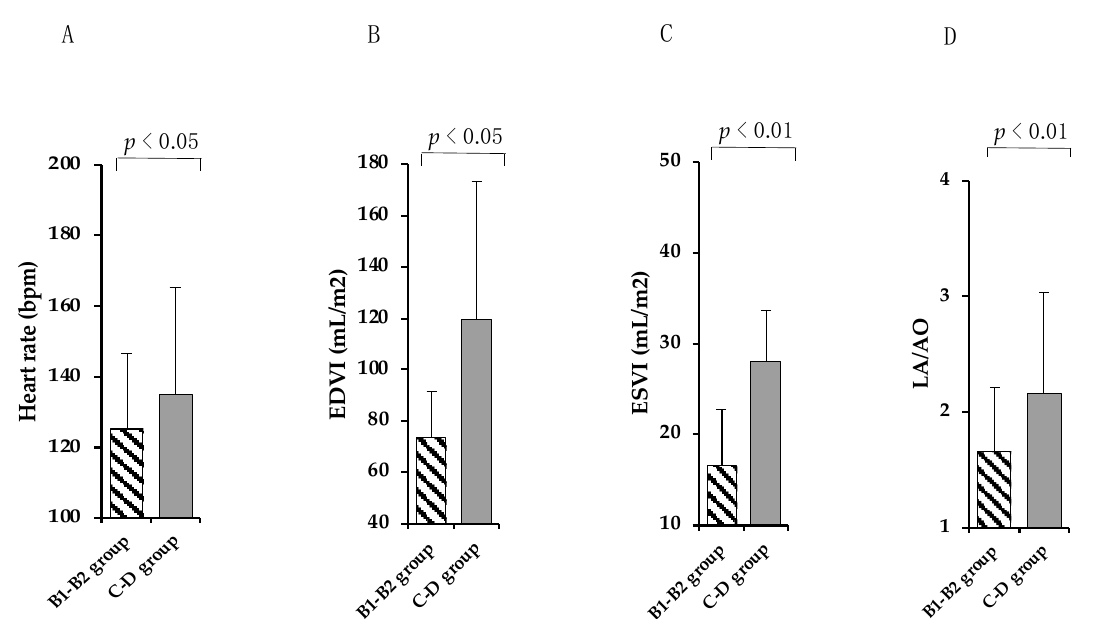
Figure 1. The echocardiographic examination of enrolled dogs. Heart rate ( A ), EDVI ( B ), ESVI ( C ), and LA/AO ratio ( D ) in the mild and moderate MMVD (B1–B2) group (dashed column) and in the severe and very serious MMVD (C–D) group of dogs (grey column). Wilcoxon’s matched-pairs signed-rank test was performed to compare the different groups. NS means “no significant difference”.